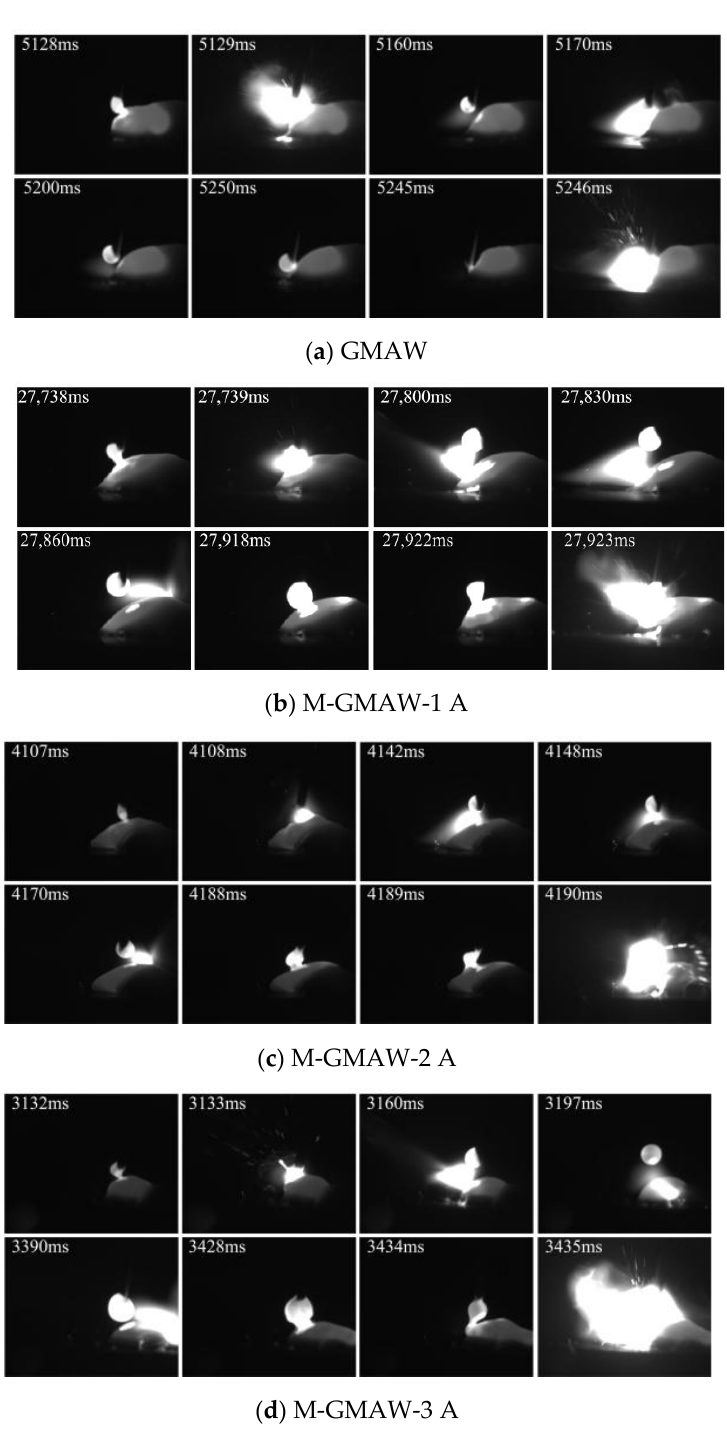
Figure 3. Wire feeding speed of 3 m/min.